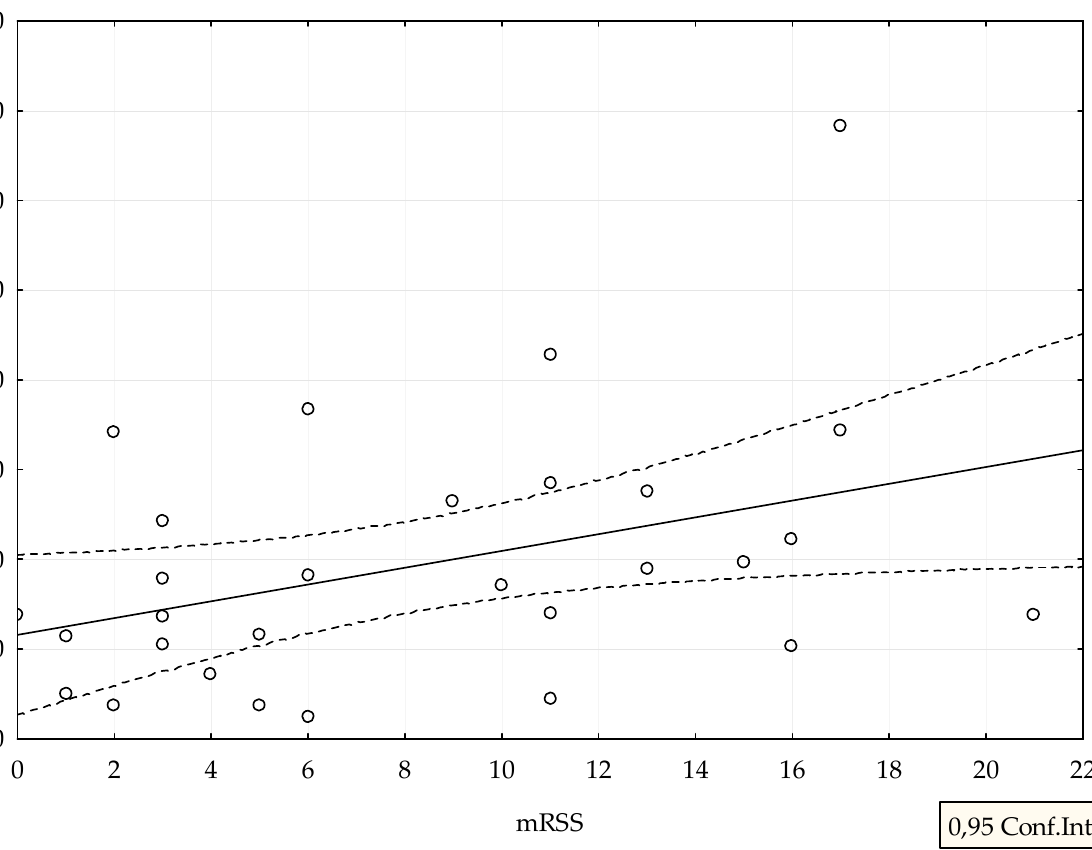
Figure 1. Correlation between mRSS and serotonin levels. Serotonin is expressed as ng/mL.